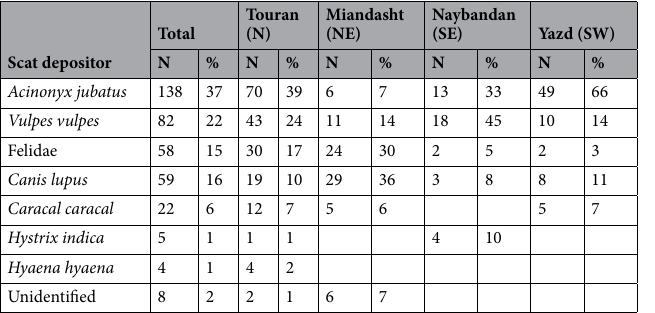
Table 2. Identity of scat depositors, number of occurrences (N) and percentage (%) in total and in each study area. Subpopulations are indicated as Northern (N), North-eastern (NE), South-eastern (SE) and South- western (SW).